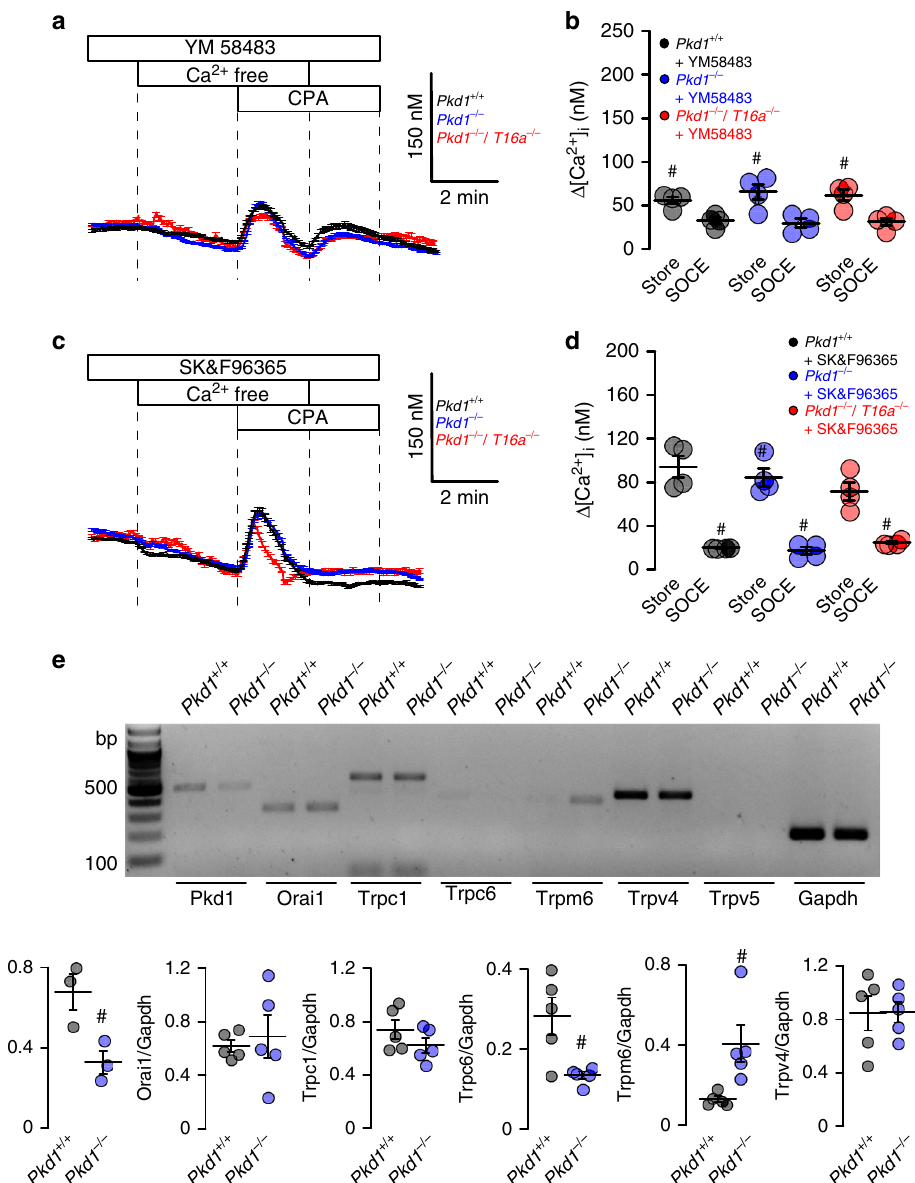
Fig. 5 Inhibition of enhanced store-operated Ca 2 + entry (SOCE) by TRP and Orai channel inhibitors. a – d Original recordings and summaries showing inhibition of upregulated ER Ca 2 + store release (Store) and store-operated Ca 2 + entry (SOCE) in primary renal epithelial cells from Pkd1 − / − mice in the presence of 5 µ M Orai channel inhibitor YM58483 ( # P < 0.0001 and # P < 0.0001, respectively) and 5 µ M TRP-channel inhibitor SK&F96365 ( # P < 0.0001 and # P < 0.0001, respectively) ( n = 73 cells from 5 independent cultures of 4 animals each). e , f Semiquantitative RT-PCR analysis of Orai1 and TRP- channel (Trpc1, Trpc6, Trpm6, Trpv4, Trpv5) expression in Pkd1 + / + and Pkd1 − / − renal epithelial cells. In Pkd1 − / − cells mRNA for Pkd1 ( # P = 0.03) and Trpc6 ( # P = 0.03) were reduced, while mRNA for Trpm1 was enhanced ( # P = 0.03) ( n = 5 reactions from 3 animals each). Mean and error bars indicating ±SEM. #§ One-way ANOVA and Tukey ’ s post-hoc test comparing Pkd1 + / + with Pkd1 − / − and Pkd1 − / − with Pkd1 − / − / T16a − / − , respectively. Source data are provided as a Source Data fi